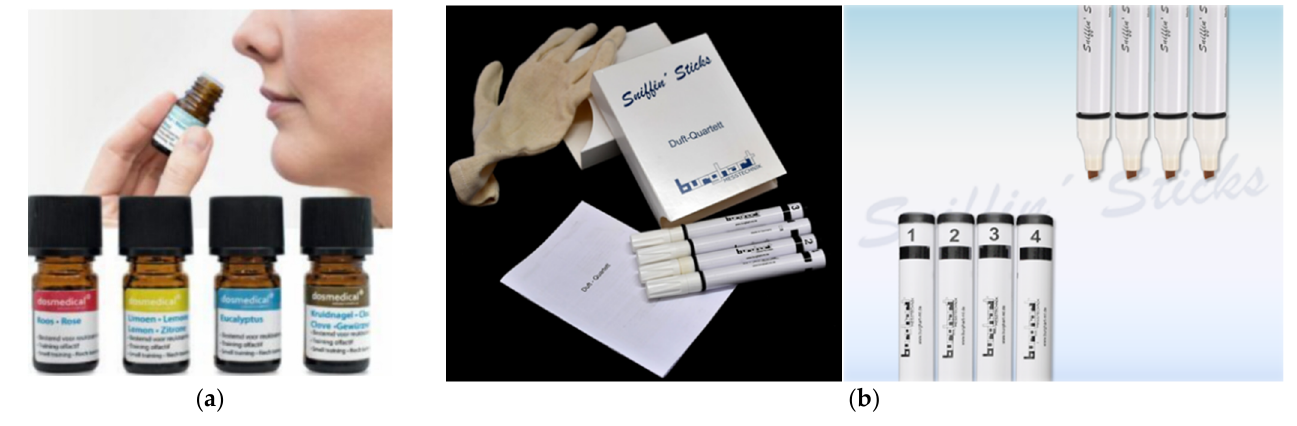
Figure 1. Display of the devices for olfactory training: ( a ) Dosmedical; ( b ) Sniffin’ Sticks.